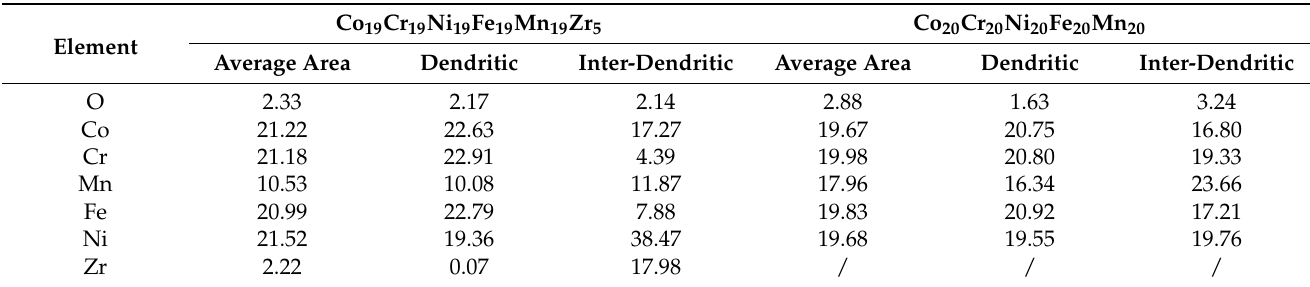
Table 2. Semi-quantitative analysis of average area, dendritic and inter-dendritic phase of as-cast specimens (each reported atomic composition is a 5-point averaged analysis).